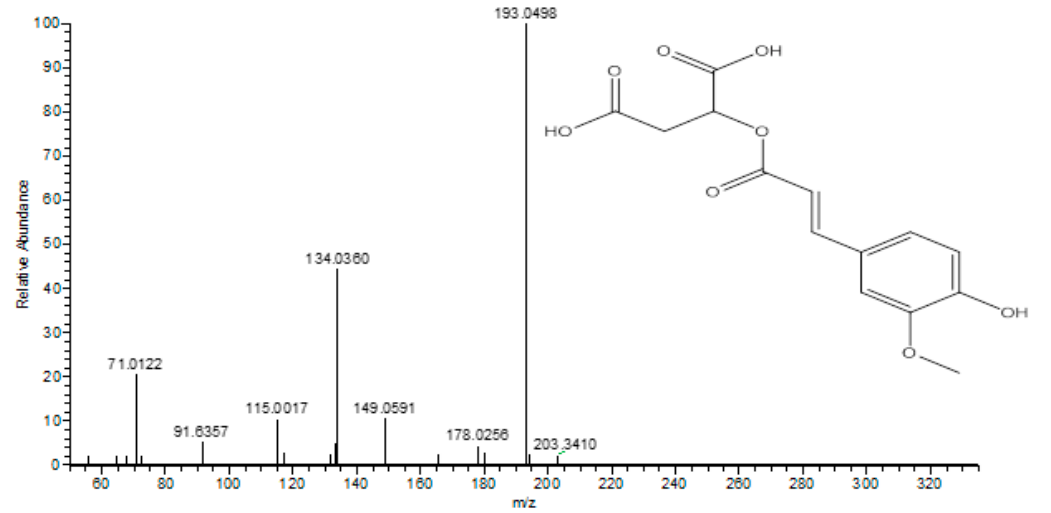
Figure 3. UPLC/MS/MS of feruloyl ‐ O ‐ malic acid ester. Identification of Flavonoid ‐ O ‐